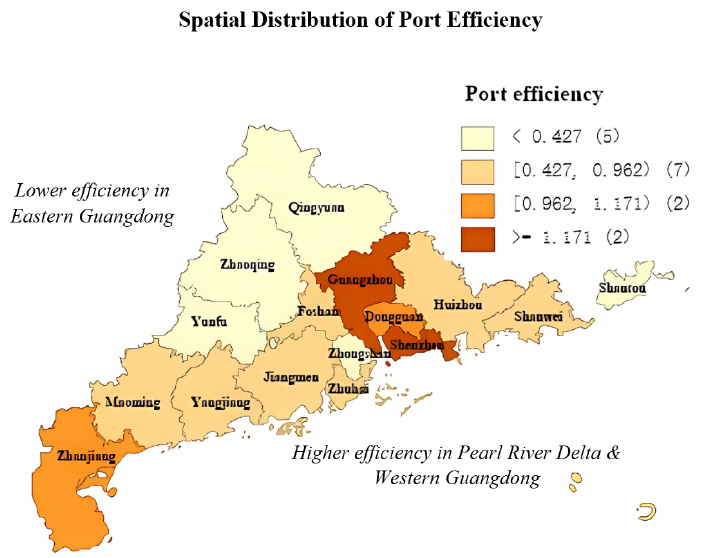
Figure 4. Spatial distribution characteristics of port efficiency.